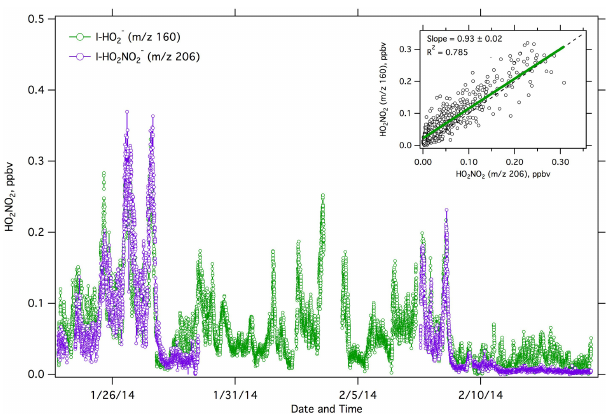
Figure 3. A comparison of HO 2 NO 2 observations made using the I–HO − ( m/z 160) ion with a hot dissociator (130 ◦ C) and the I– 2 HO 2 NO − ( m/z 206) ion with a cold dissociator ( ∼ 25 ◦ C). Inset 2 is a correlation plot of the two measurements where comparison is